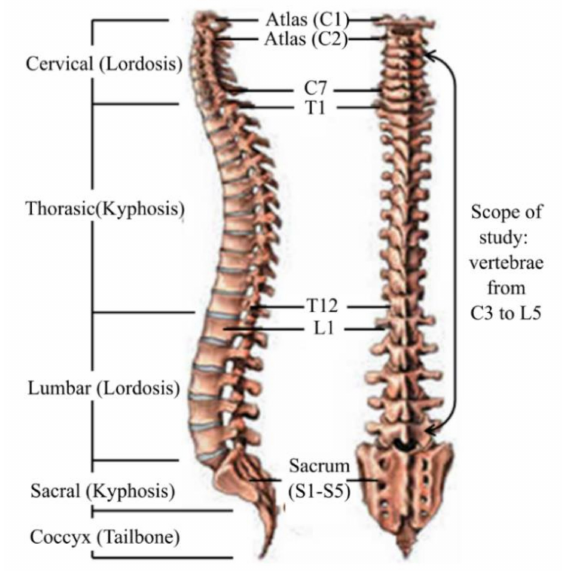
Figure 3. Human spine anatomy lateral ( left ) and posterior ( right ) view